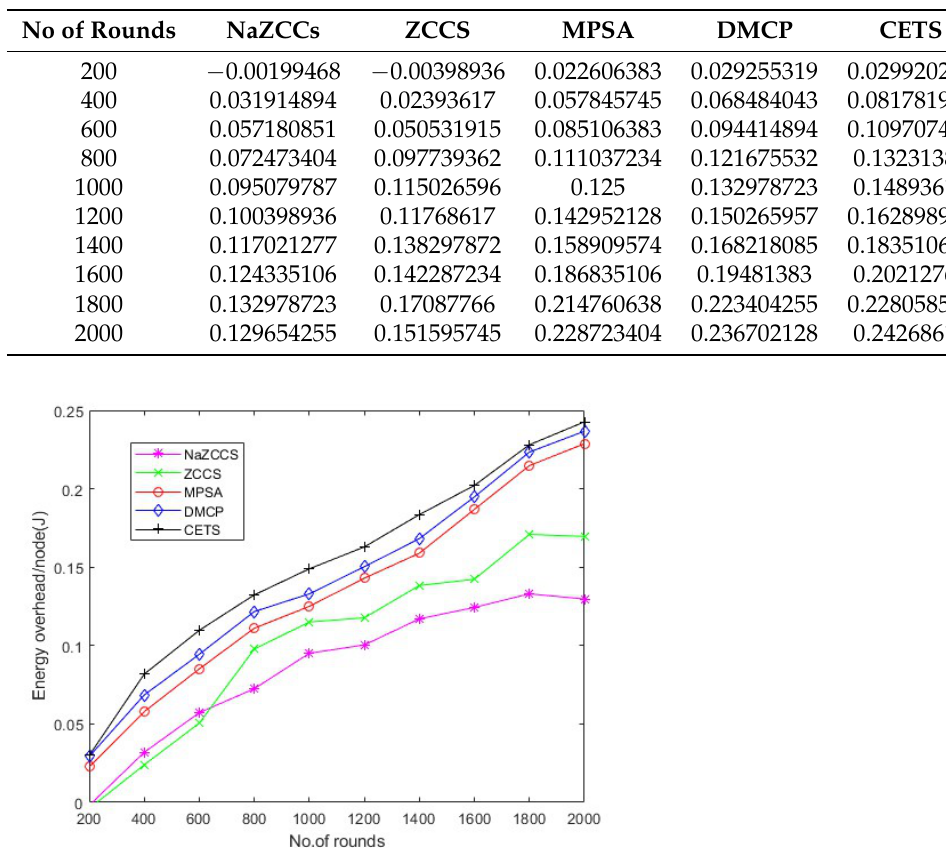
Figure 15. CETS versus other models on energy overhead per round at hop density 0.1. Table 12. CETS versus other models on energy overhead per round at hop density 0.2.